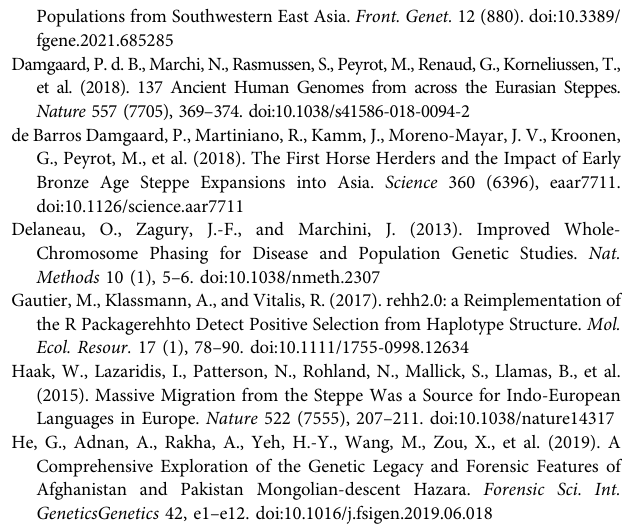
Supplementary Figure S2 | The pairwise f4 statistics in forms of f4 (studied individual1, studied individual2; Atayal, Mbuti.DG ). Z scores with 2 < |Z| < 6 were labeled as “ +/ − , ” signi fi cant Z scores(|Z| > 6) were labeled as “ ++/ −− . ” Supplementary Figure S3 | The pairwise f4 statistics in forms of f4 (studied individual1, studied individual2; Han_NChina, Mbuti.DG). Z scores with 2 < |Z| < 6 were labeled as “ +/ − , ” signi fi cant Z scores (|Z| > 6) were labeled as “ ++/ −− ” . Supplementary Figure S4 | The pairwise f4 statistics in forms of f4 (studied individual1,studied individual2; Tibetan_Chamdo, Mbuti.DG). Z scoreswith 2 < |Z| < 6 were labeled as “ +/ − ” ; signi fi cant Z scores(|Z| > 6) were labeled as “ ++/ −− ” . Supplementary Figure S5 | The pairwise f4 statistics in forms of f4 (studied individual1,studiedindividual2;Ulchi,Mbuti.DG).Zscoreswith2 < |Z| < 6werelabeled as “ +/ − ” ; signi fi cant Z scores(|Z| > 6) were labeled as “ ++/ −− ” . Supplementary Figure S6 | The pairwise f4 statistics in forms of f4 (studied individual1, studied individual2; Mongol, Mbuti.DG). Z scores with 2 < |Z| < 6 were labeled as “ +/ − ” ; signi fi cant Z scores(|Z| > 6) were labeled as “ ++/ −− ” . Supplementary Figure S7 | The pairwise f4 statistics in forms of f4 (studied individual1, studied individual2; Mongola, Mbuti.DG). Z scores with 2 < |Z| < 6 were labeled as “ +/ − ” ; signi fi cant Z scores(|Z| > 6) were labeled as “ ++/ −− ” . Supplementary Figure S8 | The heatmap of pairwise IBD (identi fi ed by descent) segments among Mongolian individuals. Supplementary Figure S9 | The shared genetic drift between ancient Eurasian populations and Mongolian subgroups. Supplementary Figure S10 | The genetic distance (Fst) based on smartpca showed the genetic difference in Eastern Eurasian among Mongolian subgroups. Supplementary Figure S11 | The phylogenetic relationships between the studied Mongolian populations and modern Eurasian populations based on Treemix. (A) . TreeMix based on relative genetic drift showed the polygenetic relationship among global populations and four-gene fl ow events. One gene fl ow occurs between Ulchi and Mongolian speaker Buryat. (B) . TreeMix-based phylogenetic tree including fewer references showed one western gene in fl ux fl ow into Mongol. Supplementary Figure S12 | The best- fi tted qpGraph-based deep population admixture history of Mongolian subgroups. Supplementary Figure S13 | PCA patterns based on the coancestry matrix of linked SNP markers. Supplementary Figure S14 | The GO enrichment analysis of Mongolian